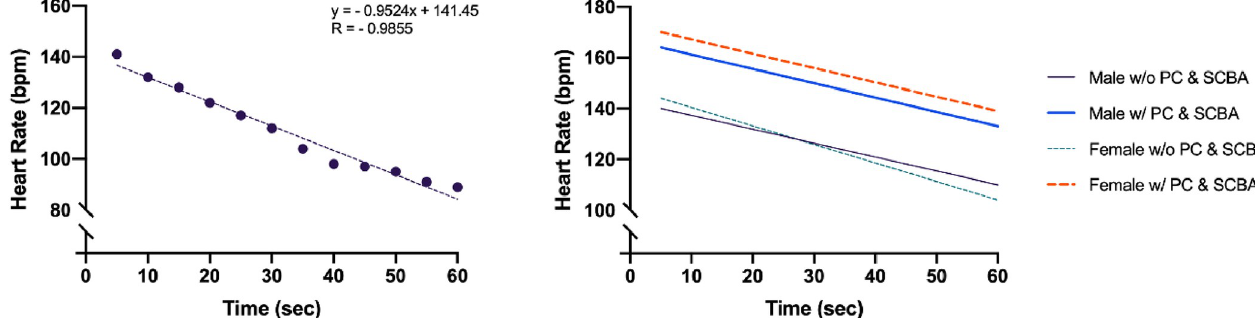
Fig 3. Heart rate trend during 1 min post Step test in all subjects (left panel). Trends of heart rate during 1 min post Step test in males and females without equipment (w/o PC & SCBA), and with equipment (w/ PC & SCBA) (right panel).